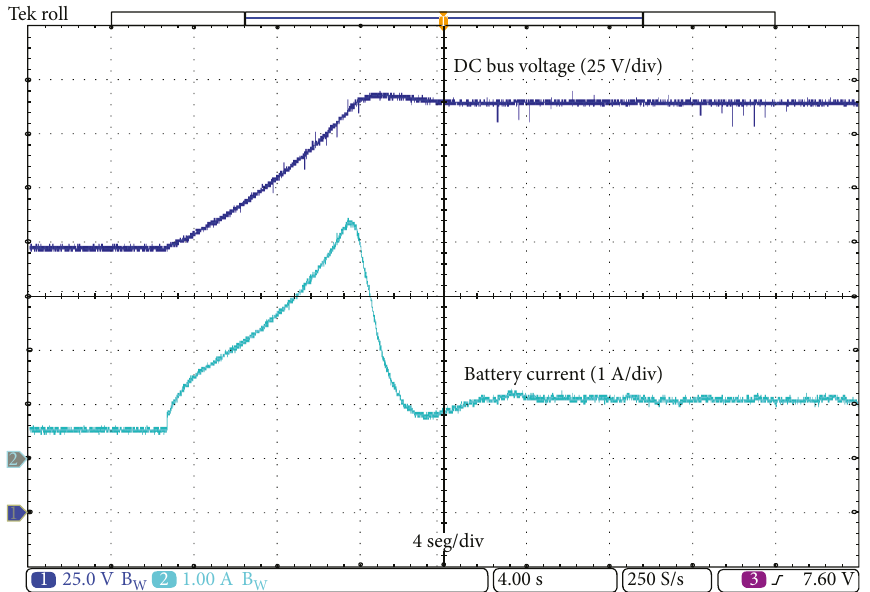
Figure 10: Behavior on starting-up the microgrid with the battery